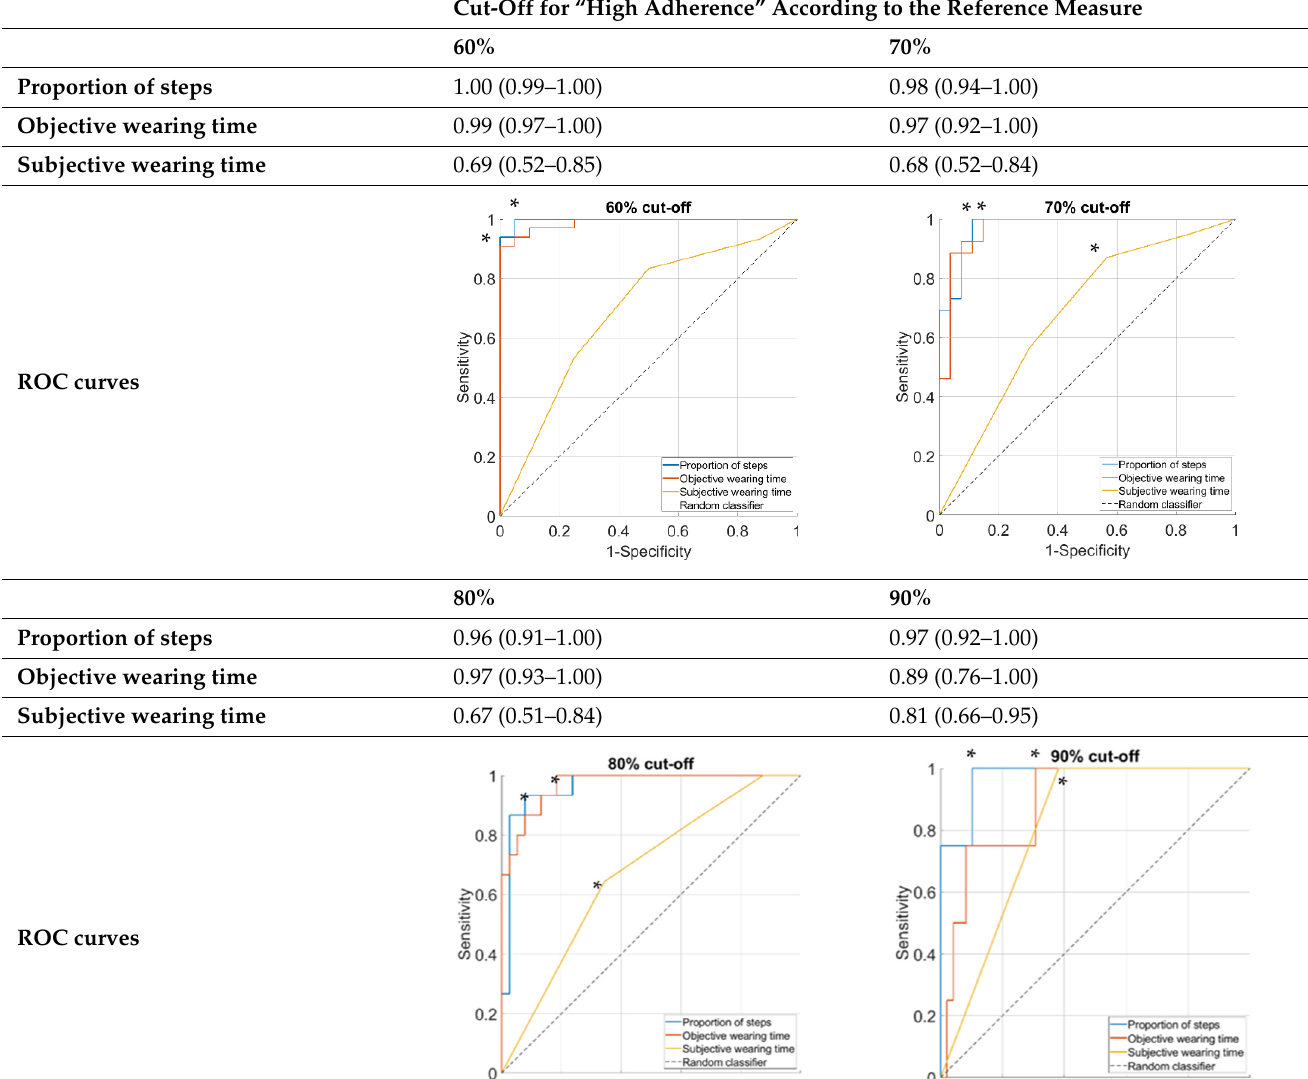
Table 2. Area under the curve (95% confidence interval) and receiver operating characteristic (ROC) curves for the associations with the reference measure.